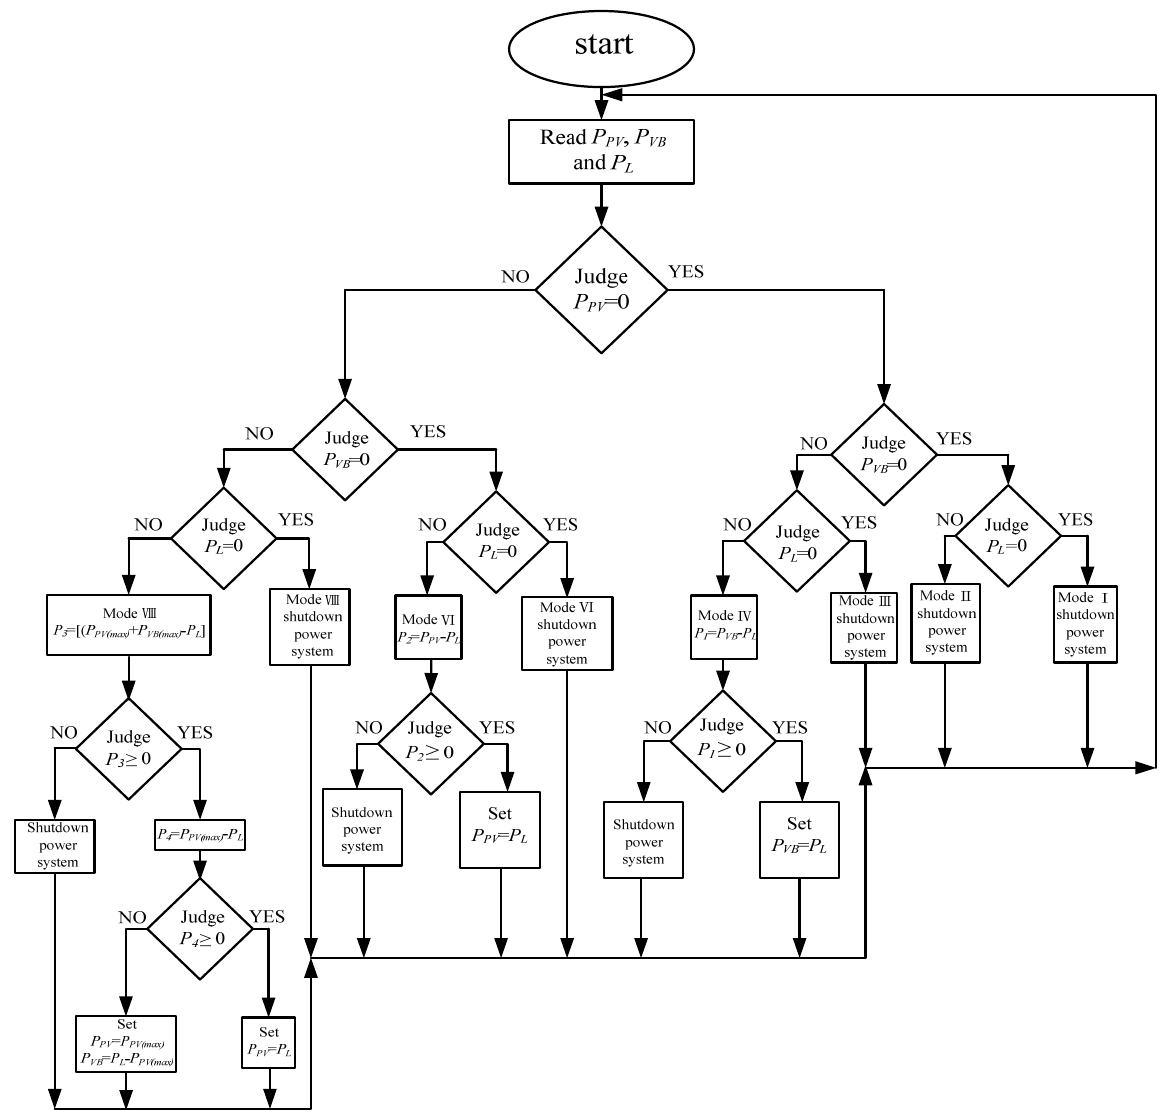
Figure 7. Flow chart of power management of the proposed PV power system.